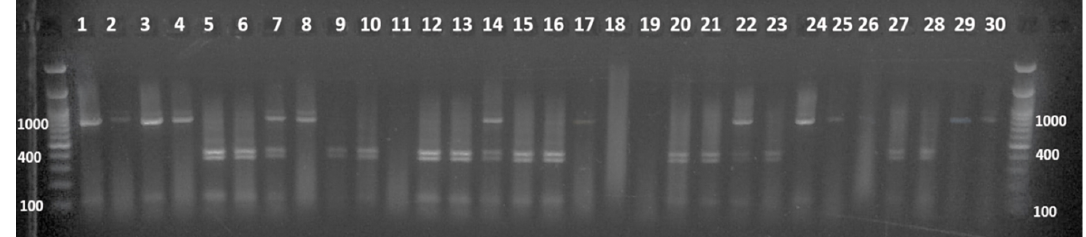
Figure 4. PCR amplification of the selected plants and parent lines with TAO marker for resistance towards Fusarium oxysporum f.sp. Lycopersici , race 2 (FOL). Lanes 1–22: selected plants; lanes 23–30: parental lines; 100 bp ladder.